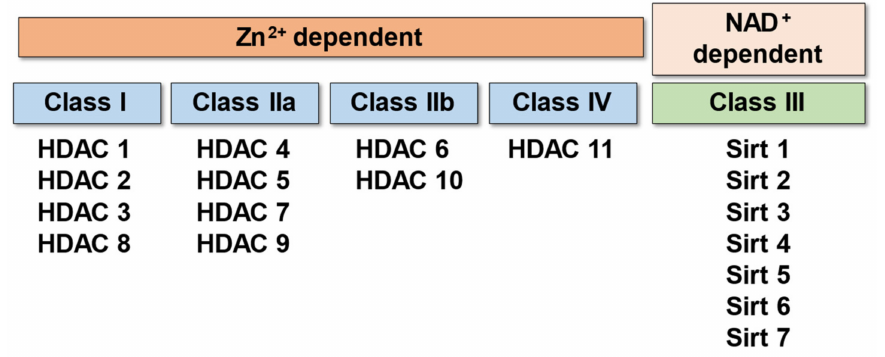
Figure 1. Classification of